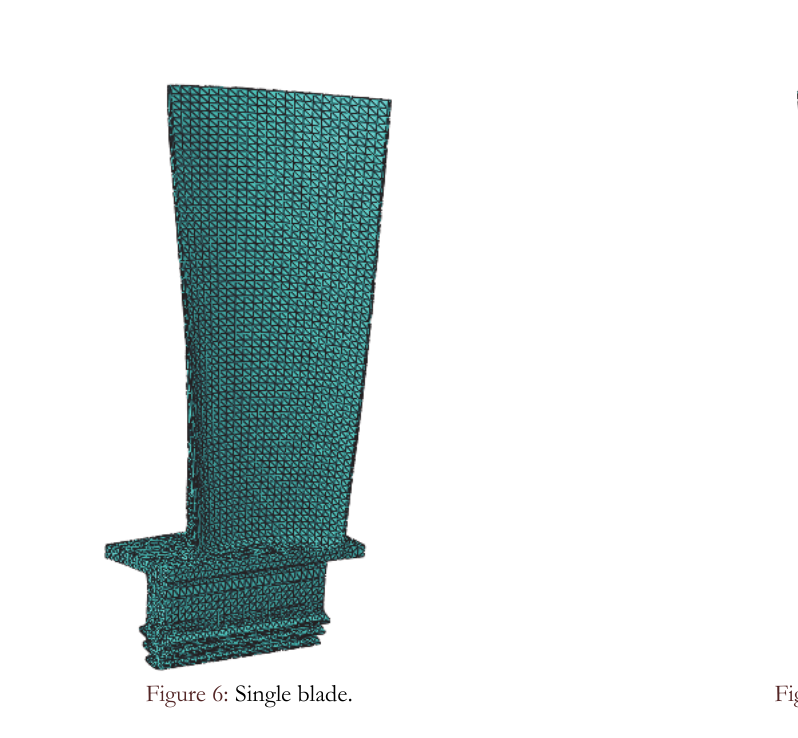
Figure 5: The structure of the TBC.